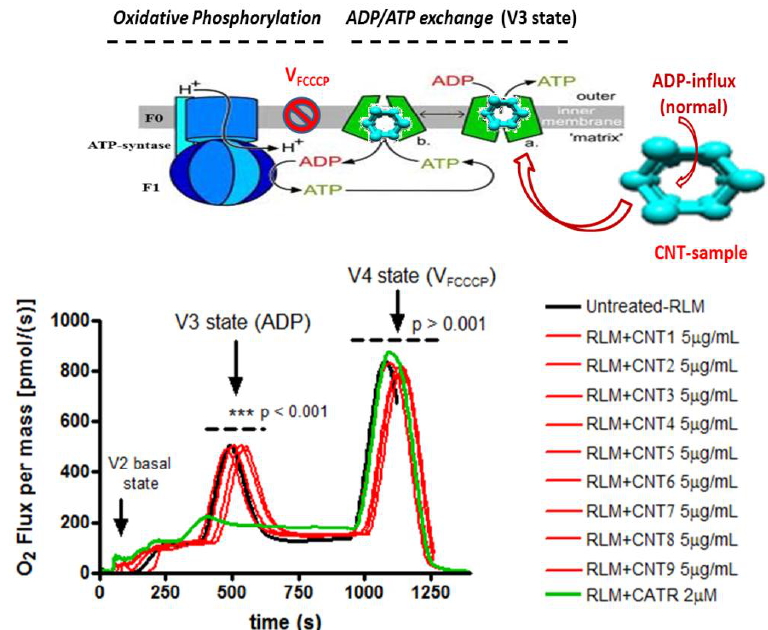
Figure 3. Representation of mitochondrial ADP/ATP exchange and oxidative phosphorylation. ***p is used to represent the significant statistical differences between V3 state-ADP-dependent mitochondrial O2 flux from the RLM + CNT treated groups (CNT1-9) and V3 state-ADP-dependent mitochondrial O2 flux from the RLM + Carboxyatractyloside (CATR, a specific inhibitor of ADP-mitochondrial transport).